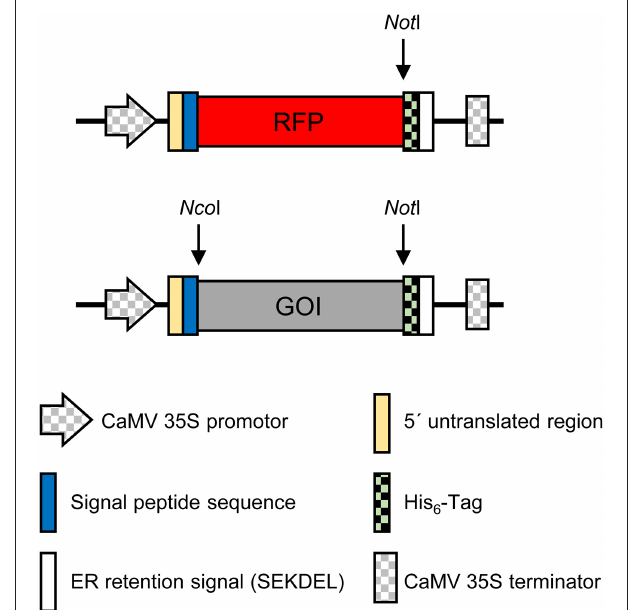
FIGURE 1 | Plant expression cassette. Schematic presentation of the expression cassettes in the plant binary expression vector pTRAkc-ERH. CaMV 35 S promoter and terminator: promoter with duplicated enhancer and terminator of the Cauliflower mosaic virus (CaMV) 35 S RNA gene; 5 ′ untranslated region: 5 ′ -UTR of the chalcone synthase gene from Petroselinum crispum ; signal peptide sequence: transit peptide sequence of the murine antibody heavy chain; RFP, red fluorescent protein from Discosoma spp. ( Bevis and Glick, 2002); GOI, Gene of interest. The restriction sites used to insert the GOI into the plant expression vector are indicated; His 6 tag: sequence encoding the six histidine affinity purification tag;